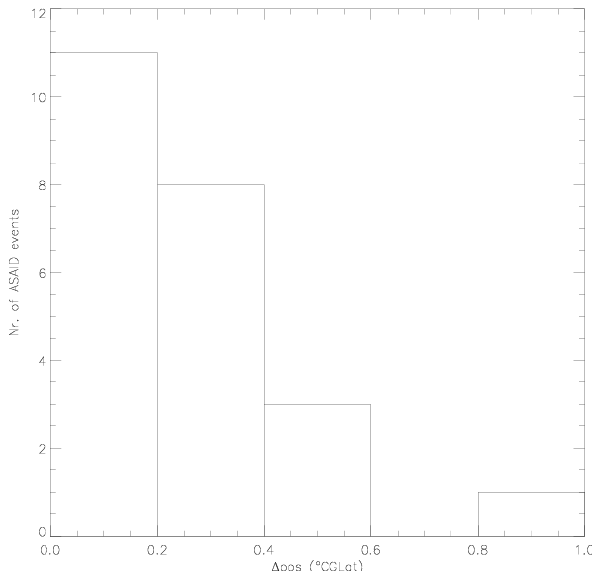
Fig. 6. Bar plot showing the number of ASAID events for different intervals of 1 pos . 1 pos represents the separation in degrees of CGLat between the peak locations of the electric and the magnetic fields. Positive values of 1 pos indicate that the electric field peak is displaced toward the region of downward flowing